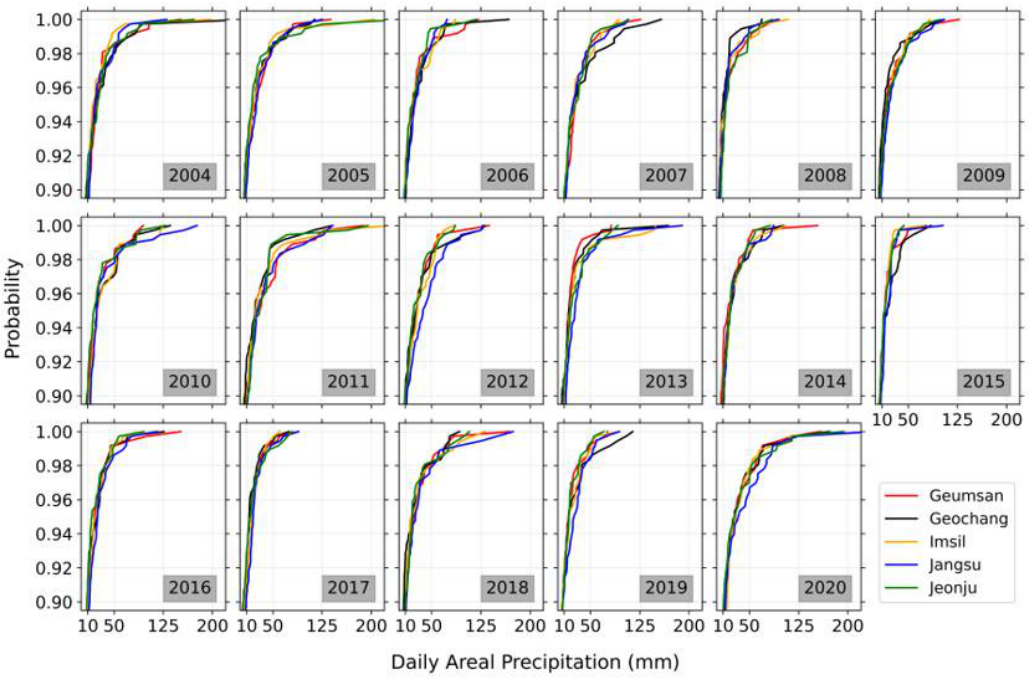
Figure 5. Occurrence frequencies of daily precipitation intensities observed at Geumsan, Geochang, Imsil, Jangsu, and Jeonju gauging stations from the year 2004 to 2020.